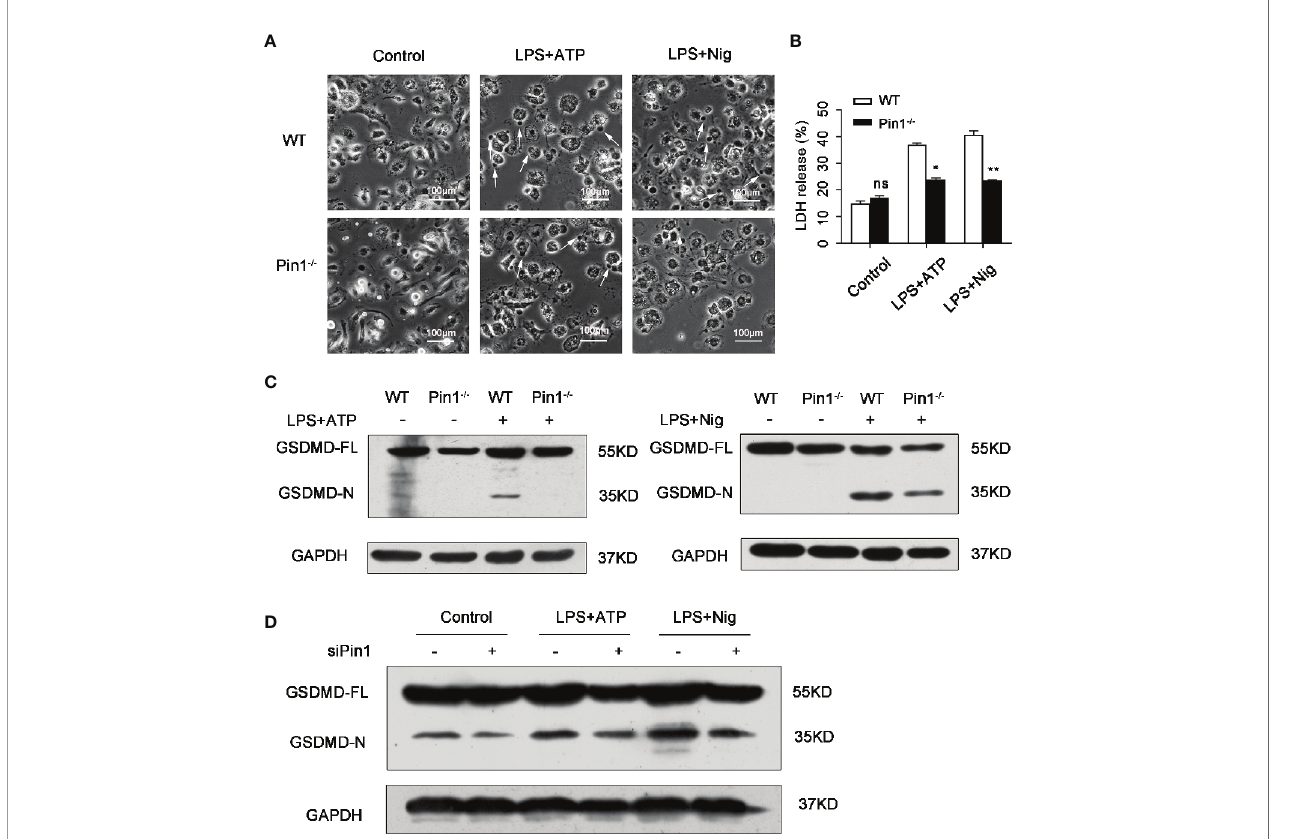
FIGURE 4 | Pin1 de fi ciency prevents caspase-1-mediated cleavage of gasdermin D (GSDMD). (A) Imaging assay of pyroptosis in WT and Pin1 -/- bone marrow- derived macrophages (BMDMs) treated with 5 mM ATP or 20 mM nigericin. (B) BMDMs were primed with 500 ng/ml LPS for 4 h and stimulated with ATP or nigericin for 30 min and supernatants were analyzed for lactate dehydrogenase (LDH). (C) Immunoblotting with mouse antibody for GSDMD in WT and Pin1 -/- BMDMs treated with ATP or nigericin. (D) Immunoblotting with mouse antibody for GSDMD in RAW 264.7 cells transfected with control siRNA or siRNA for Pin1 treated with 5 mM ATP or 20 mM nigericin for 30 min. All data are representative of three independent experiments. The data represent the mean ± SD of one among three biological replicates, with three technical replicates each. *P < 0.05; **P < 0.01; ***P < 0.001; ns, no signi fi cance; two-way ANOVA (B)